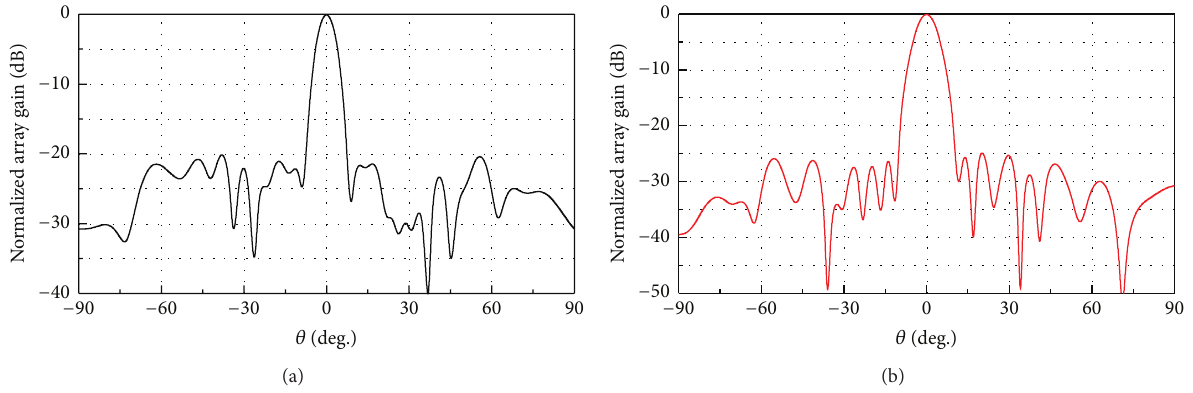
Figure 8: Optimized gain patterns of the two conformal sparse arrays. (a) CA-I. (b) CA-II.